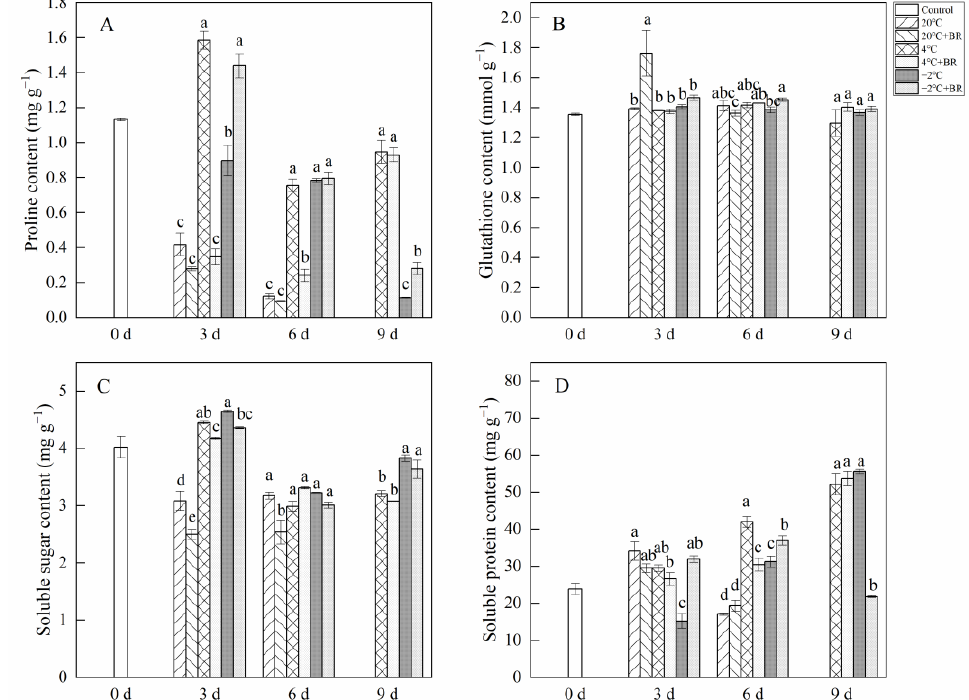
Figure 5. Effects of BR treatment on SOD activity ( A ), POD activity ( B ) of T. sinensis during different temperature storage. Bars with different letters are significantly different at the same storage time under different temperatures and BR treatment ( p < 0.05). Values are the mean of four replicates ± SE.